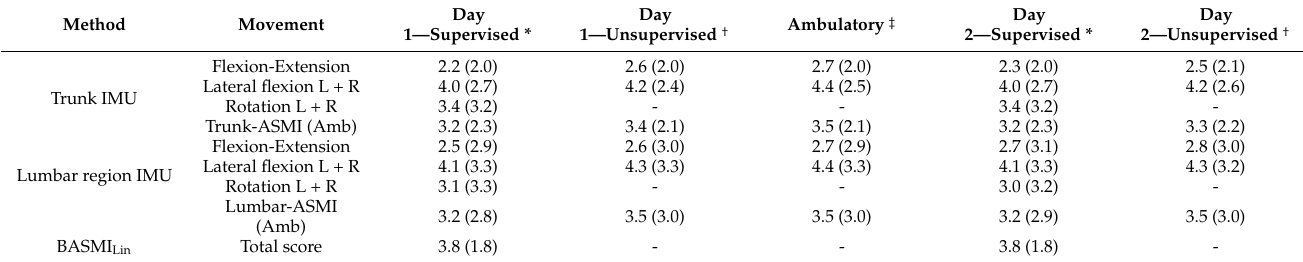
Table 4. Normalized indices for each IMU movement and composite IMU-ASMI (Amb) score per IMU